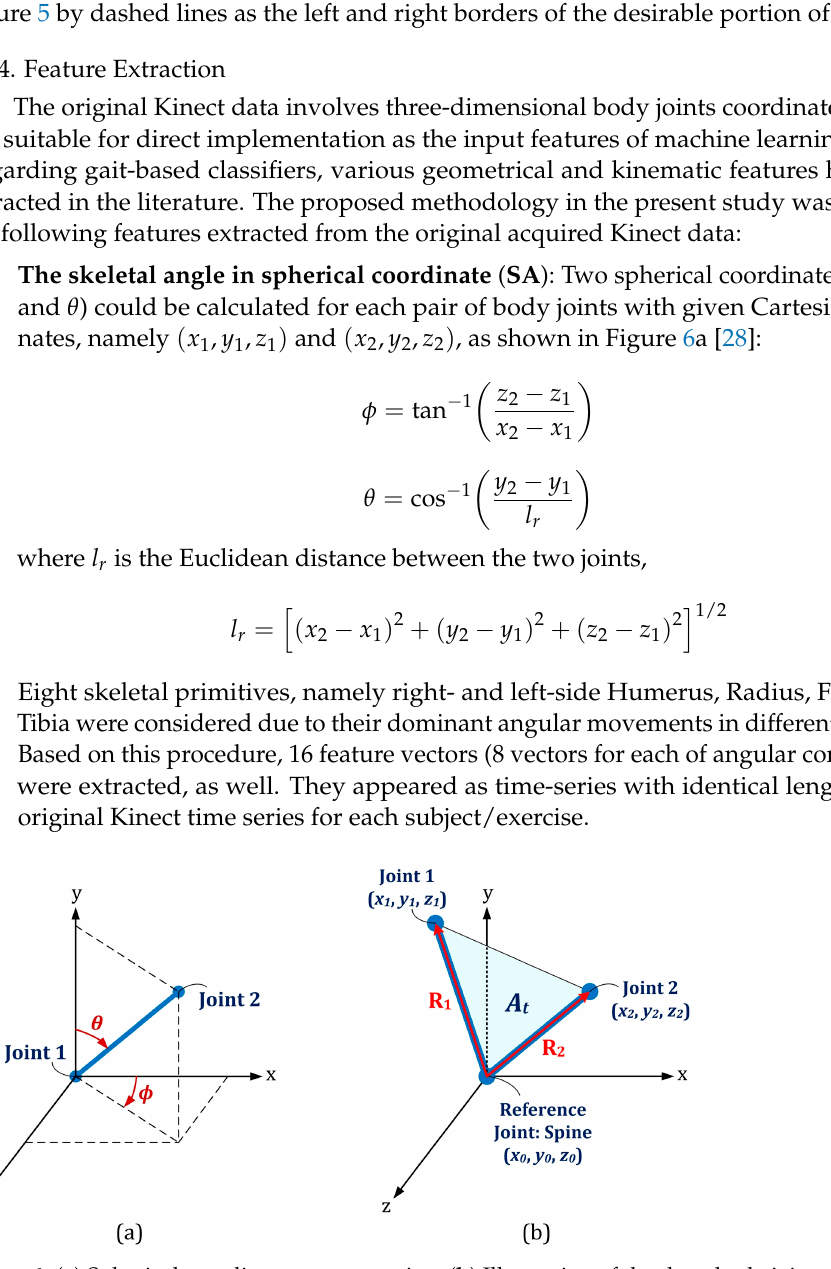
Figure 6. Temporal variation of distance metrics for the four different exercises of the present study: ( a ) ‘Arm Curled’; ( b ) ‘Gait Analysis’; ( c ) ‘Repeatedly Sit and Stand’; and ( d ) ‘Two-minute definition of cosine dissimilarity and joint triangular Step’. For each of exercises, one complete cycle was identified based on the extremum locations and the rules defined in Table 2.